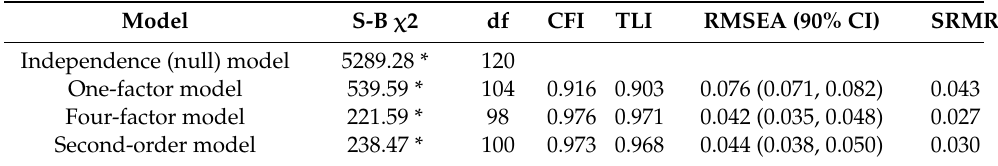
Table 2. Confirmatory factor analysis fit statistics of the